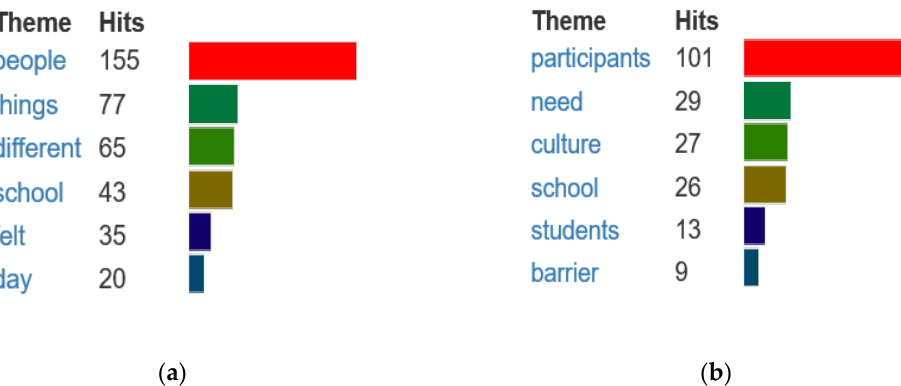
Figure 4. ( a ) Frequency table participant interviews; ( b ) frequency table leader interviews.